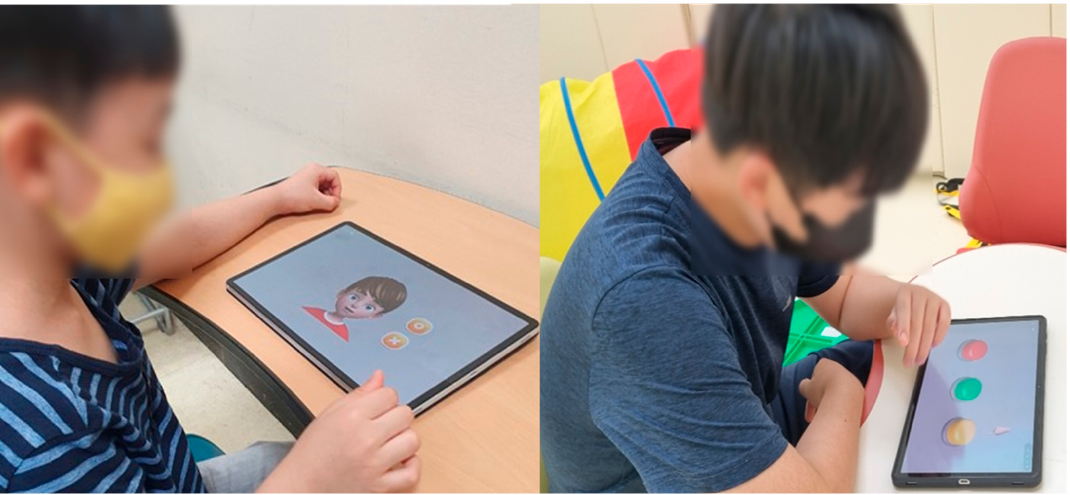
Figure 3. Digital social skills testing using a tablet-based app, patent application 10-2020-0168431 (Republic of Korea, 2022). Table 6. Social skills assessment.